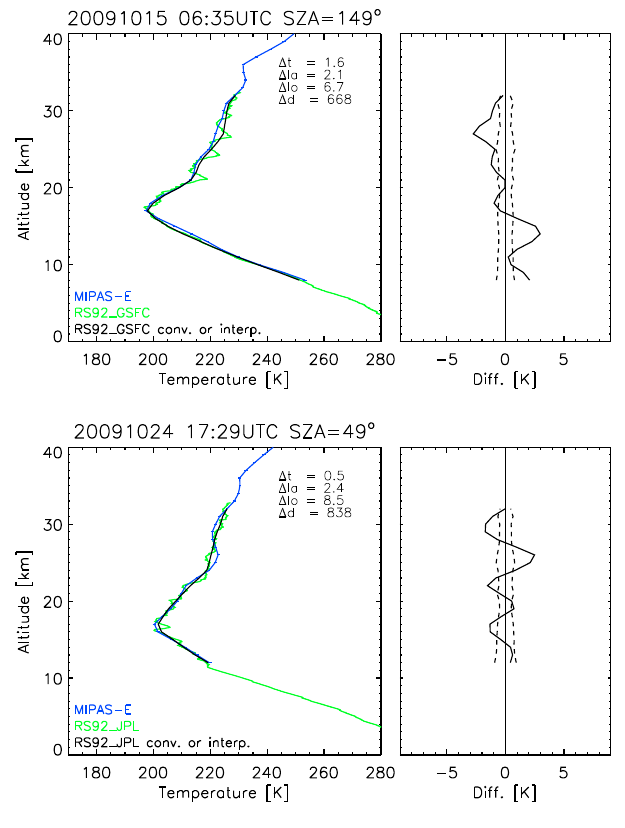
Fig. 5. Same as Fig. 1 but for RS92 GSFC (top) and RS92 JPL (bottom) radiosonde temperature profiles. For a more detailed de- scription see Fig. 1.